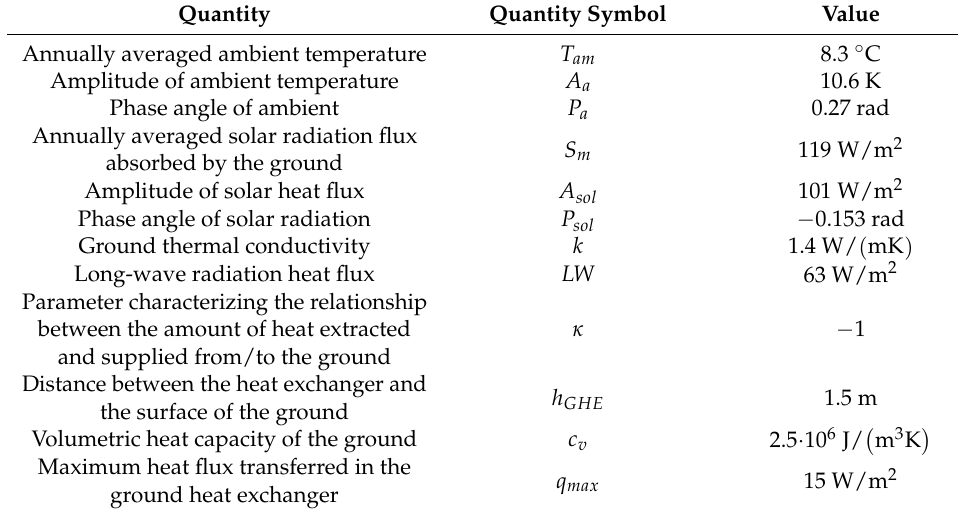
Table 2. Summary of the values of quantities present in the model and used in simulation calculations concerning the influence of RH , f and h on the minimum ground